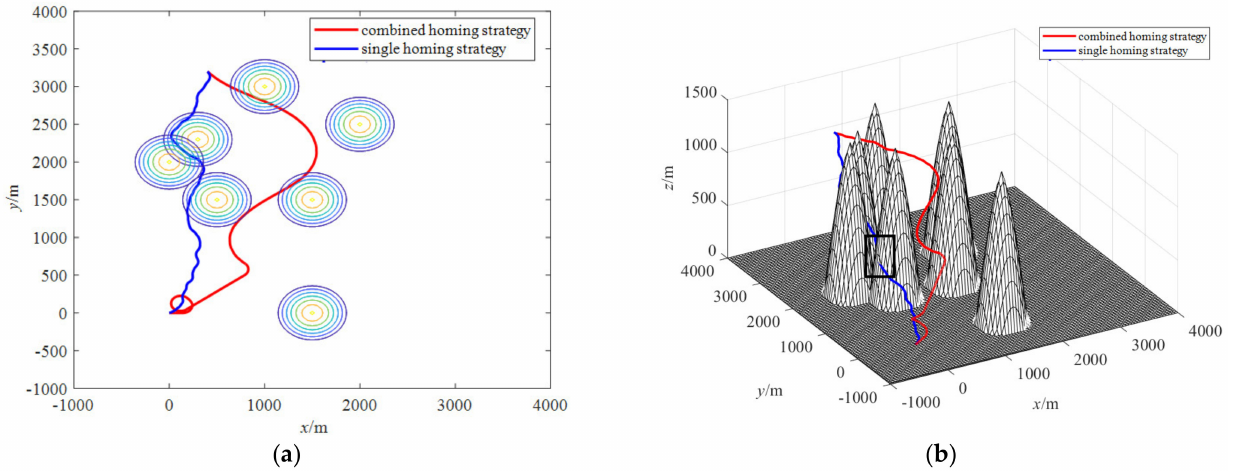
Figure 5. Result of trajectory planning of the parafoil system: ( a ) trajectories in the plane; ( b ) 3D trajectories.